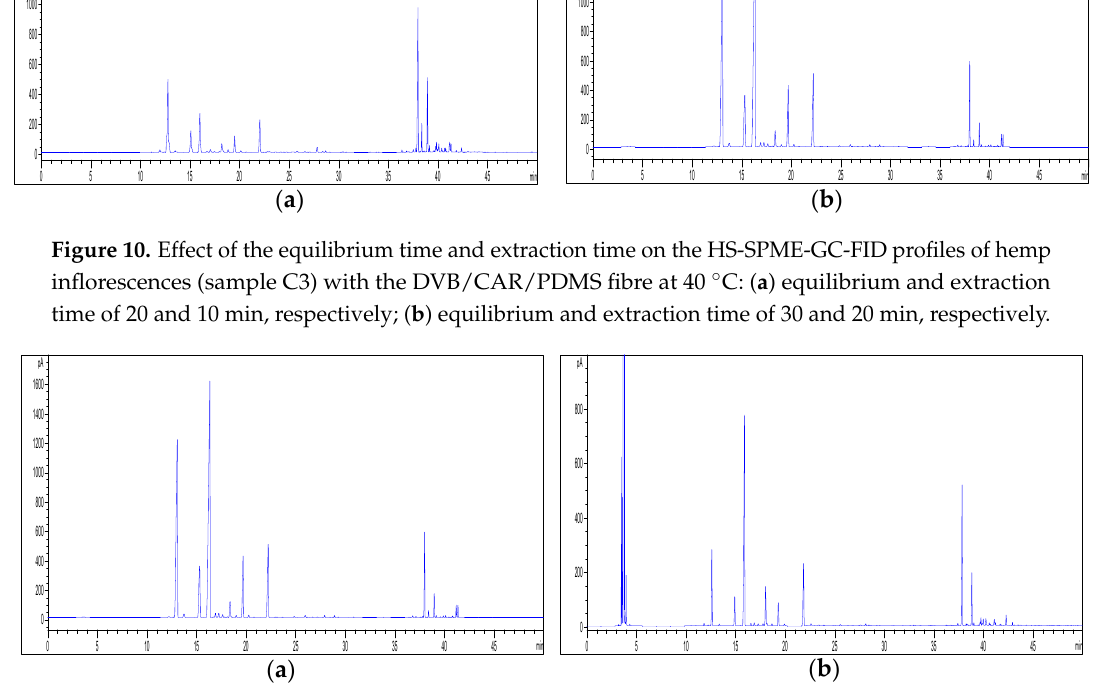
Figure 11. ( a ) GC-FID chromatogram of hemp inflorescences obtained by applying the HS-SPME procedure optimized (sample C3); ( b ) GC-FID chromatogram of the essential oil of hemp sample C3.